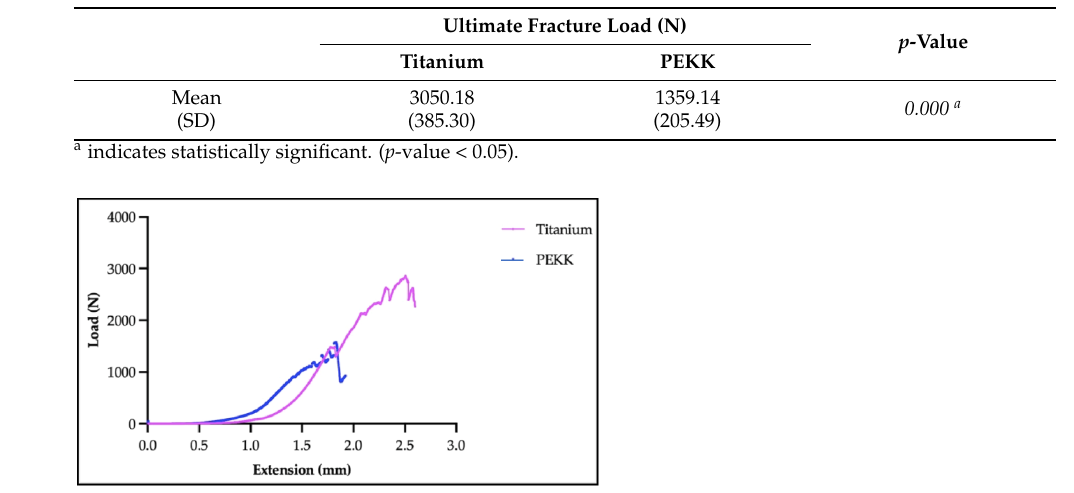
Table 4. Fracture load (N) of three-unit FPDs fabricated with different materials after five-year simulated aging.